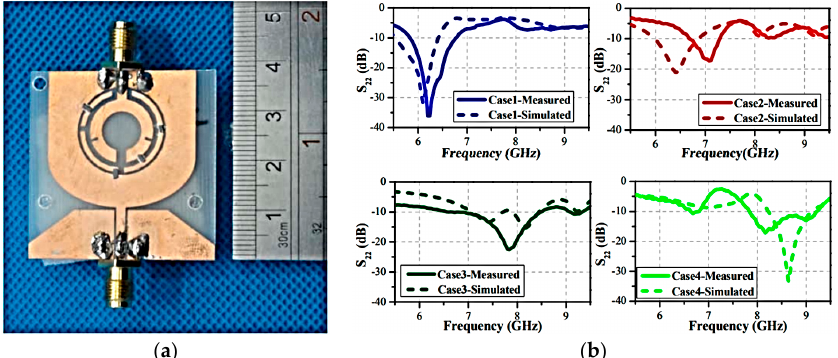
Figure 5. ( a ) Fabricated Prototype and ( b ) measured/simulated results (redrawn from [49]).